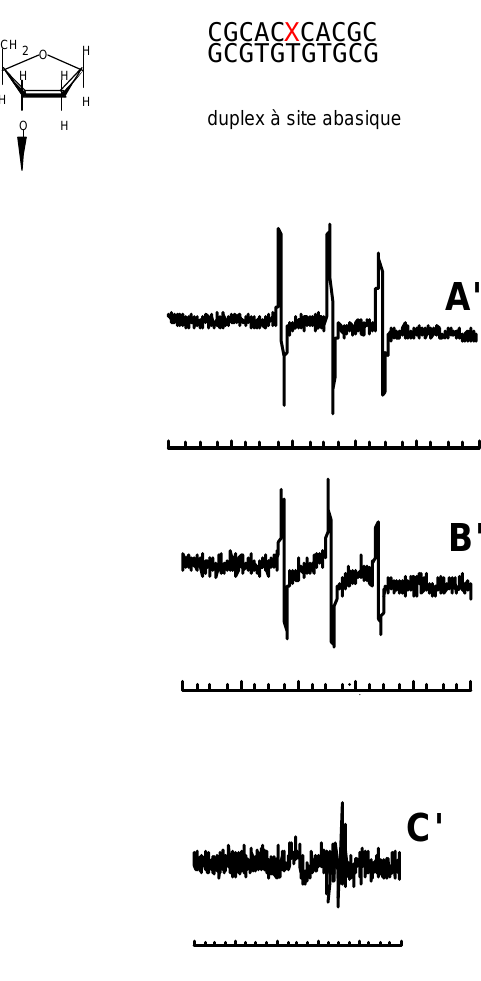
Figure 12. Recognition of abasic sites in DNA by cyclobisacridine 1 : EPR